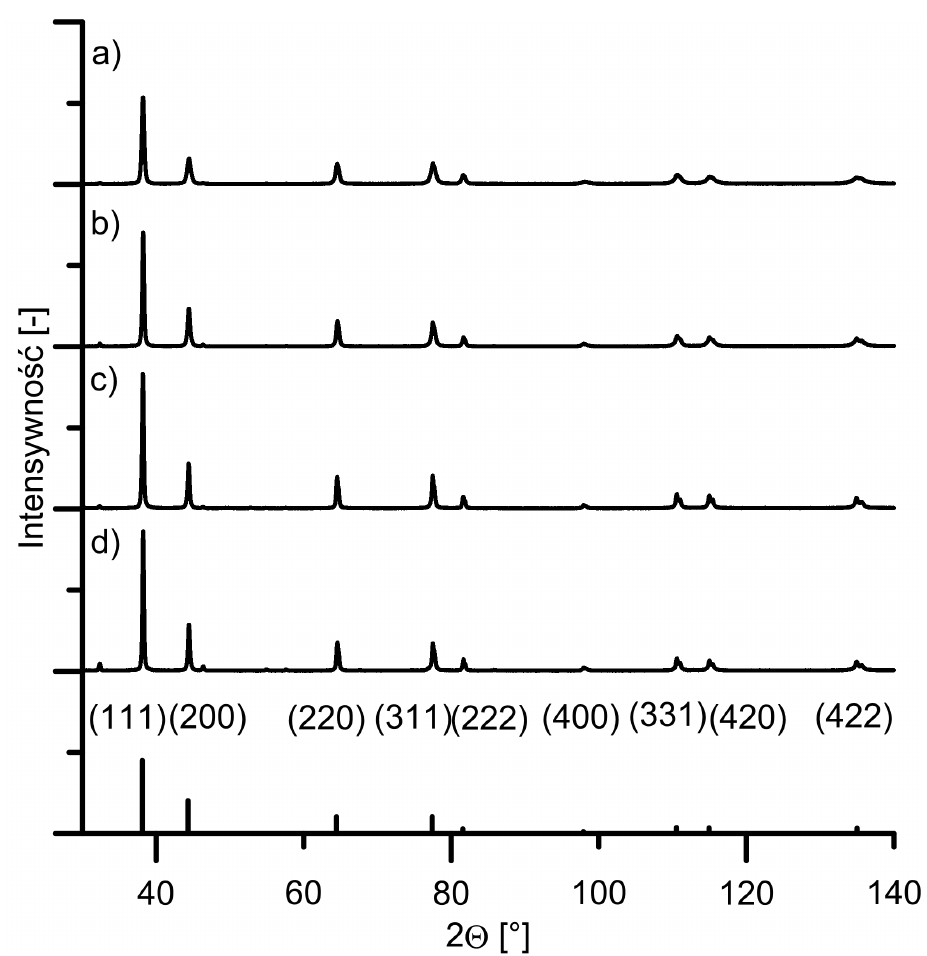
Figure 2. XRD patterns of the silver structures prepared in the conventional heating process, reductant ( a ) 1,3-butanediol or ( b ) 1,3-propanediol, and a microwave-assisted process, reductant ( c ) 1,3-butanediol or ( d ) 1,3-propanediol.